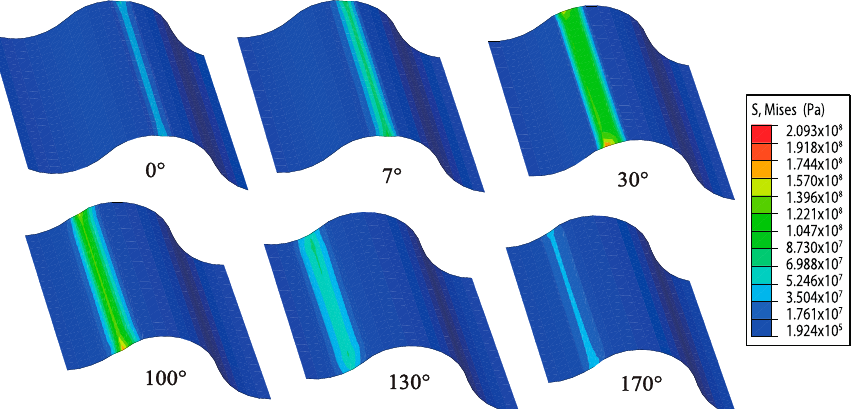
Figure 5. Finite element (FE) model of RV reducer: ( a ) exploded view and ( b ) mesh calculation.